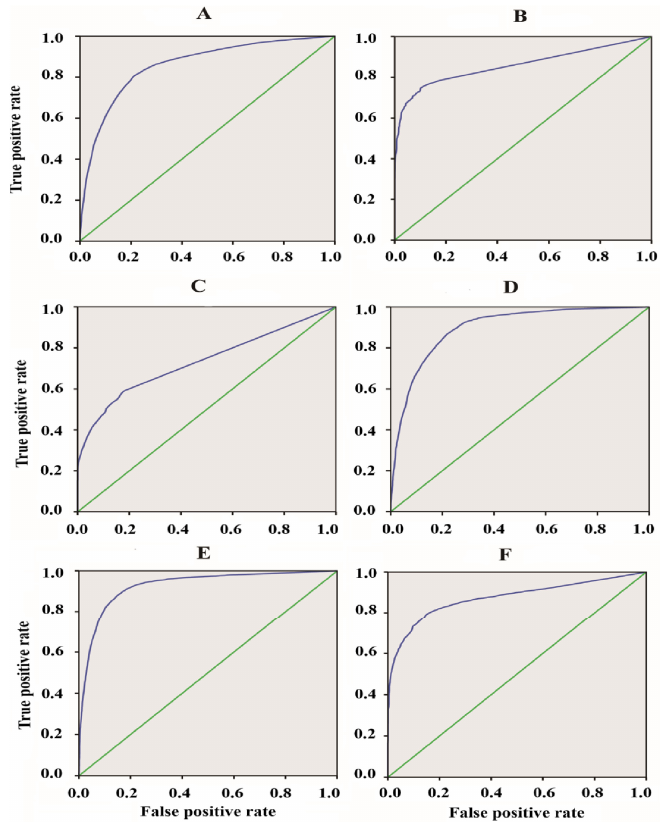
Figure 4. The receiver operating characteristic (ROC) curves of ARF-binding sites predicted using our data fusion method. The ARF members (4, 13, 14, 18, 35, and 39) were depicted by the alphabetic letters from ( A – F ), respectively. The true positive rate was evaluated as follows: TPR = TP/(TP + FN) and the false positive one FPR = TN/(TN + FP). The reference lines are displayed in green color for all the ARFs members.